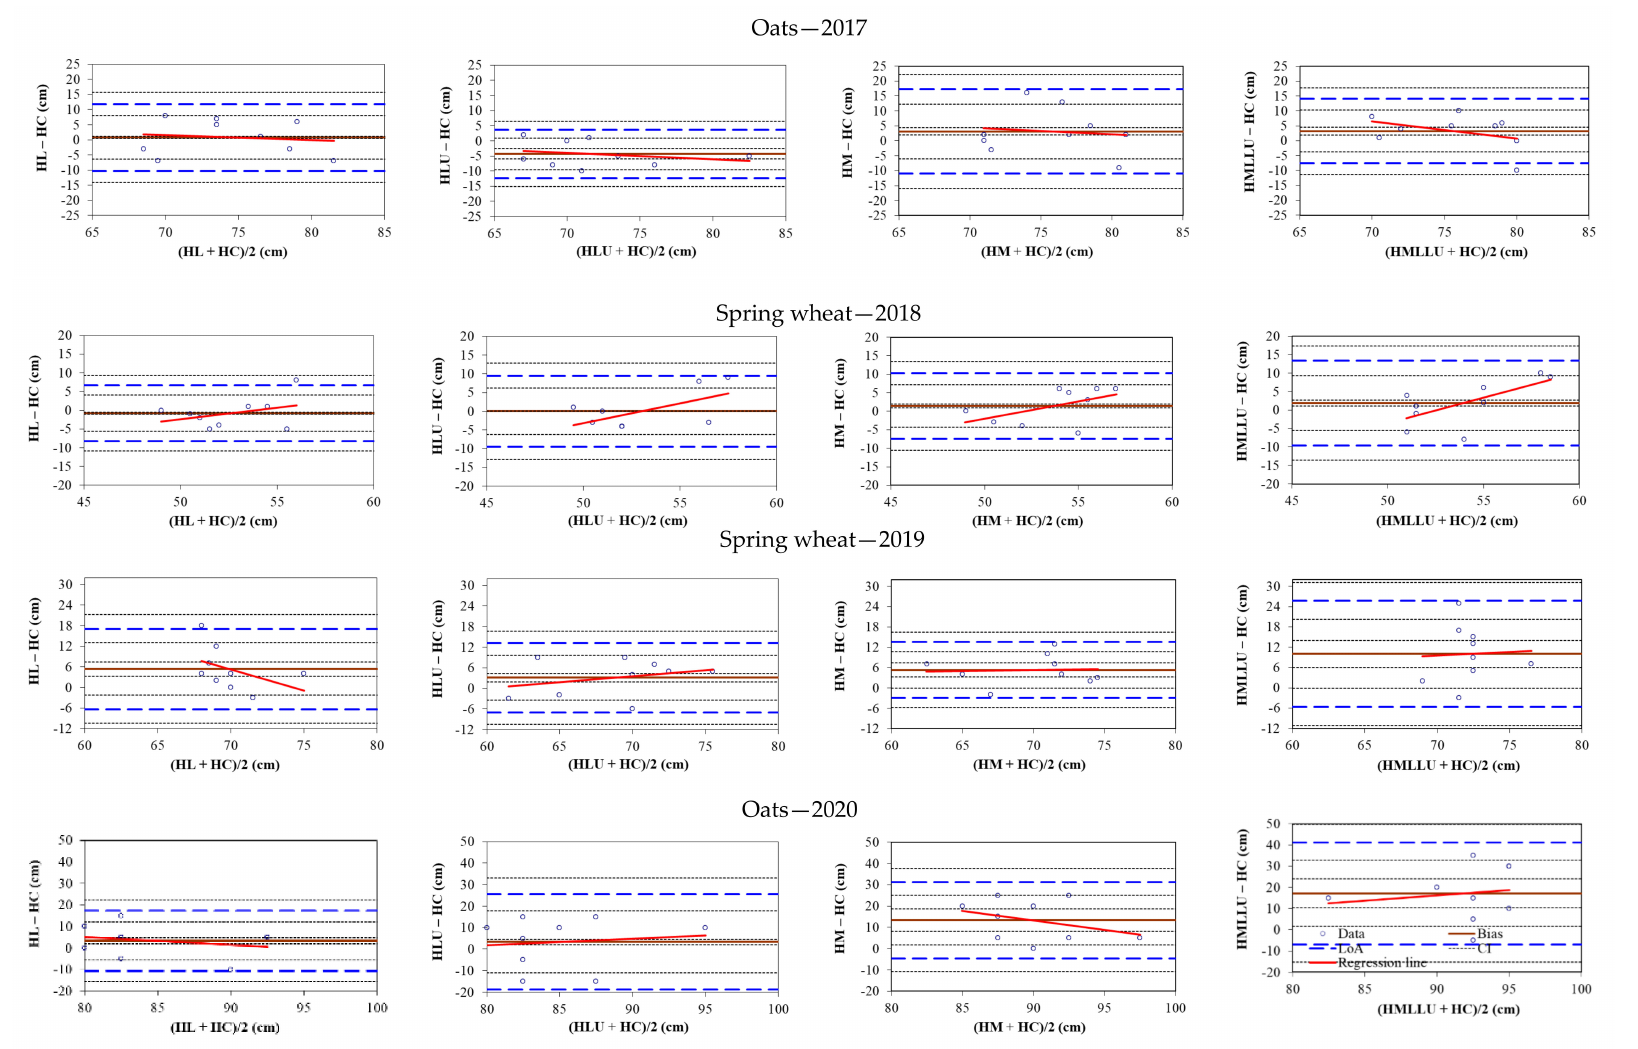
Figure 5. Bland–Altman plots for plant height (H) (cm) (oats—2017), (spring wheat—2018, 2019), (oats—2020). C—control, L—liming, LU—leguminous catch crops, M—farmyard manure, and MLLU—farmyard manure + liming + leguminous catch crops, LoA—limits of agreement, CI—confidence